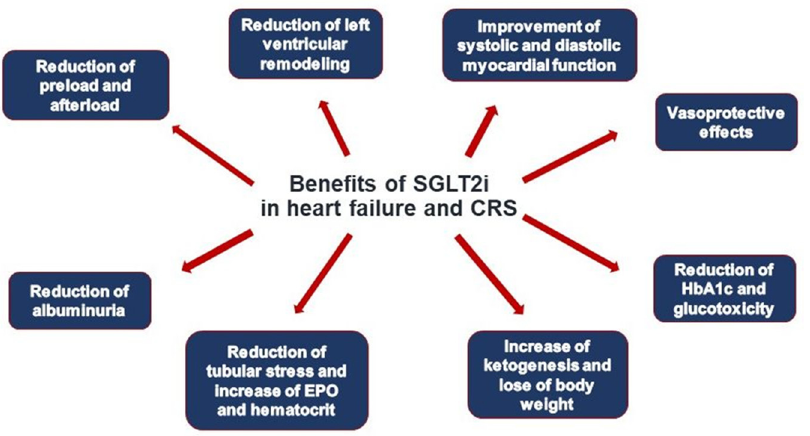
Figure 3. Benefits of SGLT2i in heart failure and CRS.